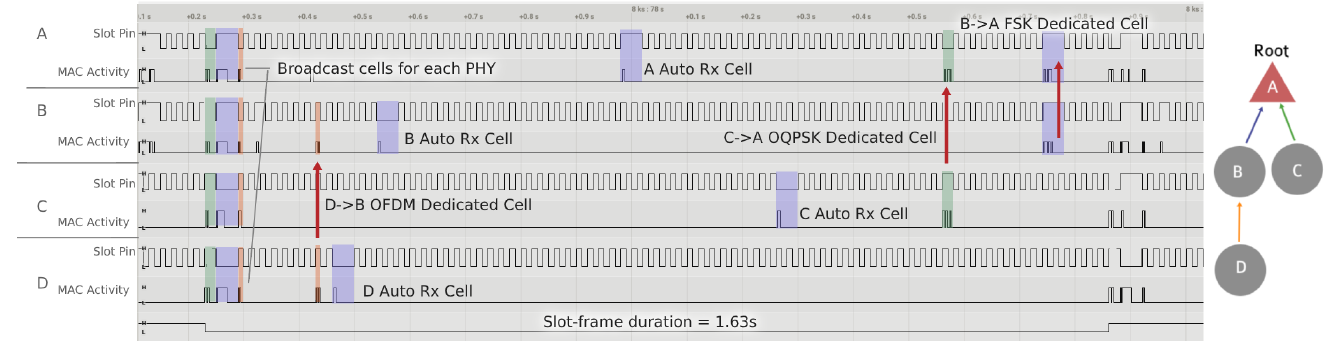
Figure 9. Logic analyzer trace showing the activity of four motes implementing 6DYN and forming a multi-hop network. The resulting schedule corresponds to Figure